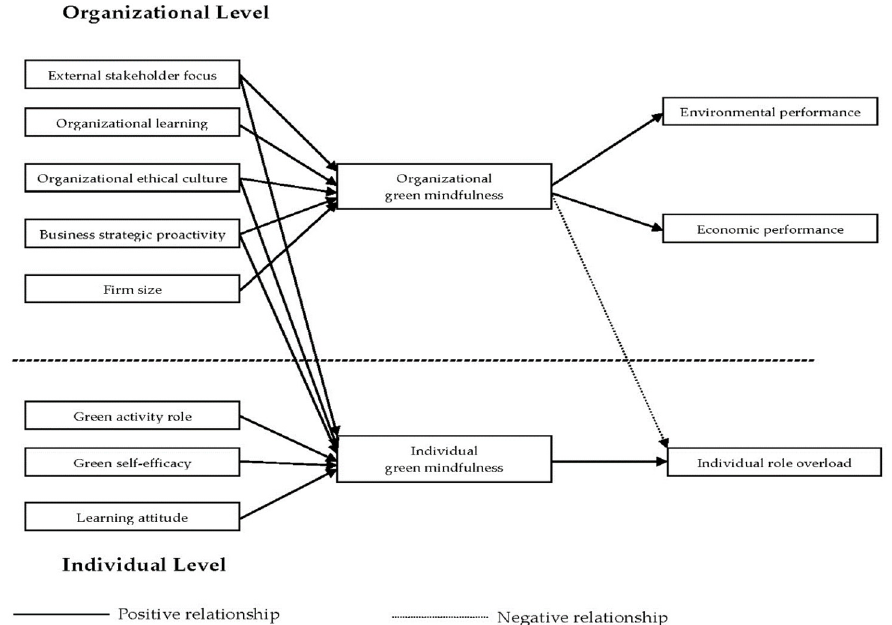
Figure 1. Conceptual Model.